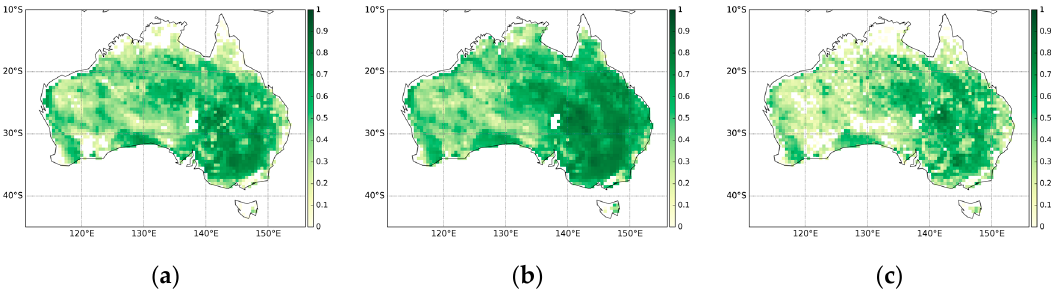
Figure 6. The Pearson correlation coefficient between FAPAR and Climate Change Initiative (CCI) soil moisture during the years 2001–2015: ( a ) MODIS, ( b ) CGLS, ( c ) QA4ECV.